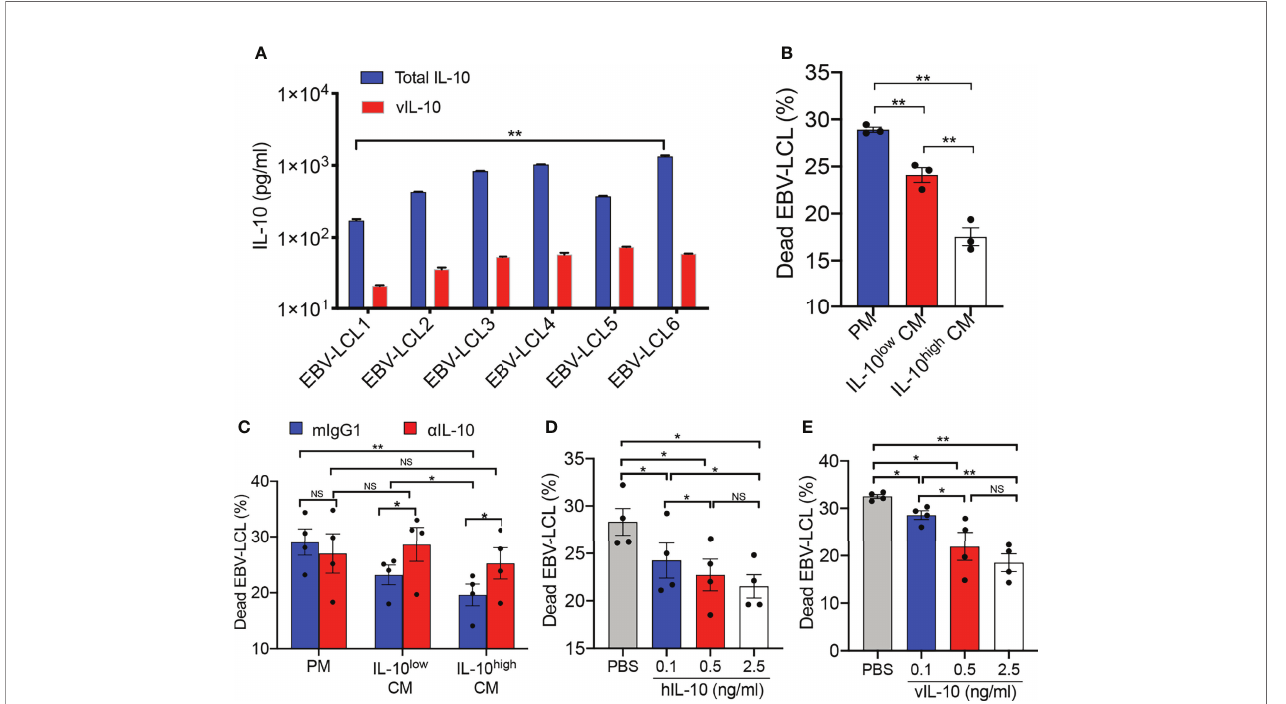
FIGURE 1 | Antitumor activity of V g 9V d 2-T cells was inhibited by IL-10 secreted from EBV-LCL in vitro . (A) The concentration of vIL-10 and total IL-10 in conditioned medium (CM) collected from EBV-LCL established from different donors were detected. (B) Puri fi ed V g 9V d 2-T cells were pretreated in the IL-10 low CM and IL-10 high CM separately for 24 h, RPMI 1640 with 10% FBS medium (plain medium, PM) as a control. Pretreated V g 9V d 2-T cells then cocultured with autologous EBV-LCL at an effector: target (E:T) ratio of 10:1 for 4 – 6 h in the IL-10 low/high CM and PM, respectively. Cytotoxicity was calculated as the proportion of dead EBV-LCL (CD3 - PI + ). (C) Puri fi ed V g 9V d 2-T cells were pretreated with IL-10 low CM, IL-10 high CM or PM in the presence of a neutralizing anti-IL-10 mAb ( a IL-10, 5 m g/ml) or isotype control (mIgG1, 5 m g/ml), then cocultured with autologous EBV-LCL at an E:T ratio of 10:1 for 4 – 6 h in the IL-10 low/high CM and PM respectively. Cytotoxicity was calculated as the proportion of dead EBV-LCL (CD3 - PI + ). (D, E) Puri fi ed V g 9V d 2-T cells were pretreated with recombinant hIL-10 (D) or vIL-10 (E) at different concentration, then cocultured with autologous EBV-LCL at an E:T ratio of 10:1 for 4 – 6h. The proportion of dead EBV-LCL (CD3 - PI + ) were detected by fl ow cytometry. All data are shown as mean ± SEM and representative of three independent experiments. *p < 0.05; **p < 0.01; ns, no signi fi cant